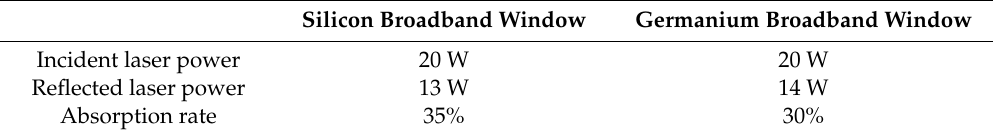
Table 3. Absorption rate of the 1.06 μ m laser by a flat window.